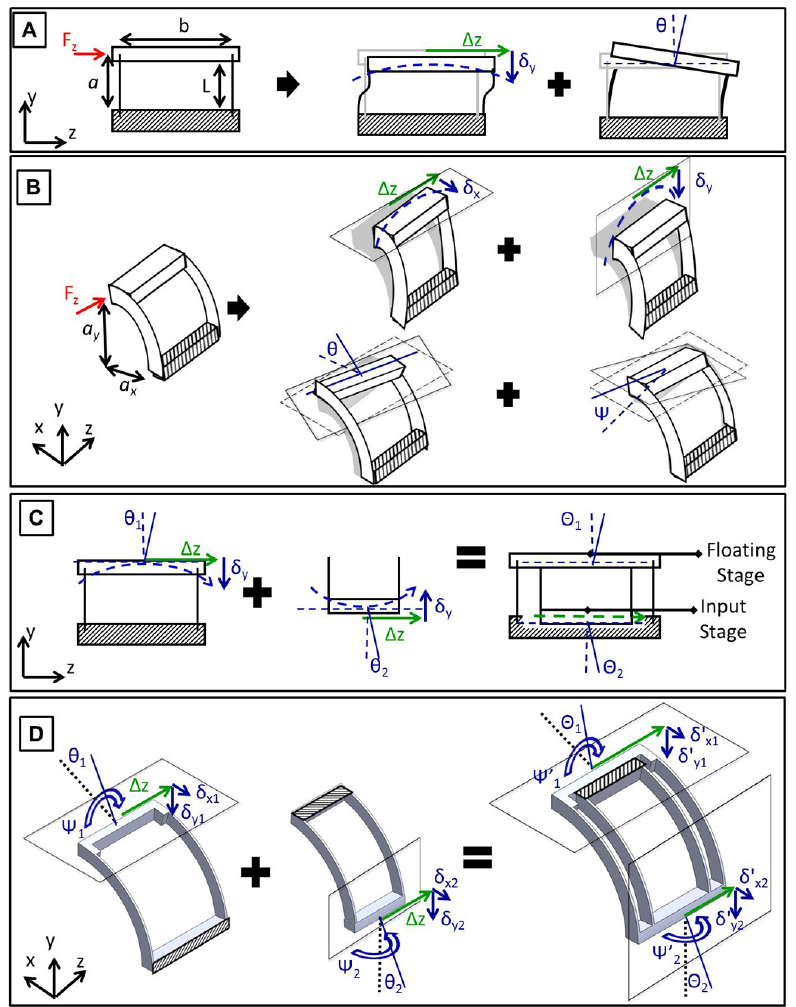
Figure 3. (A) Straight four-bar linkage parameters, a indicates the location of F z relative to ground. Figure shows the three motions associated with F z applied onto the platform. Desired displacement ∆ z is indicated with green, while the parasitic motions, θ and δ y , are shown in blue. (B) Curved four-bar linkage parameters and displacements under F z ; a y and a x indicate the location of the force relative to ground. The curvature results in two δ parasitic motions, δ x and δ y , and an additional rotation of the stage, Ψ . (C) Straight compound-spring. Nesting of the two four-bars results in cancellation of the δ parasitic motions. Θ 1 and Θ 2 indicate the rotations of the stages in the nested system. (D) Curved compound-spring. Cancellation of the δ motions is not straight